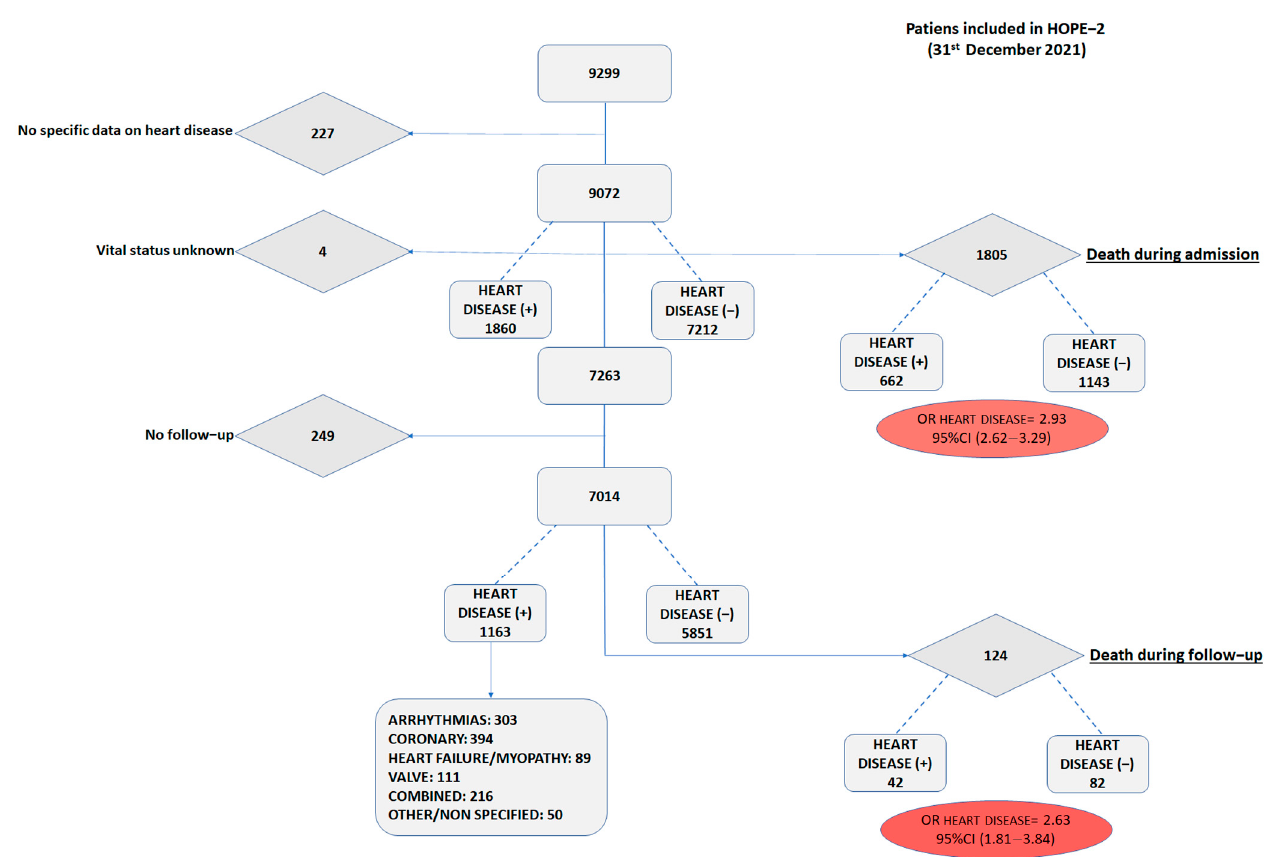
Figure 1. Study flow diagram.